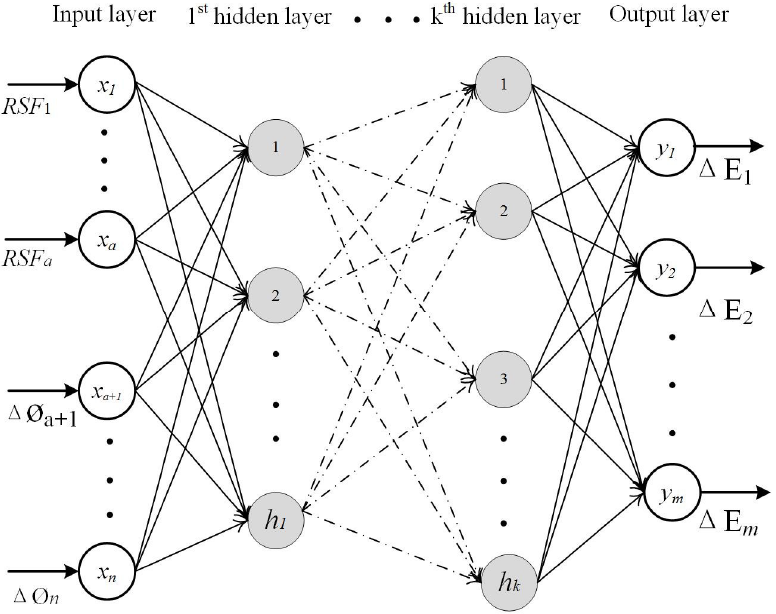
Figure 2. Structure of the BP (backpropagation) network.